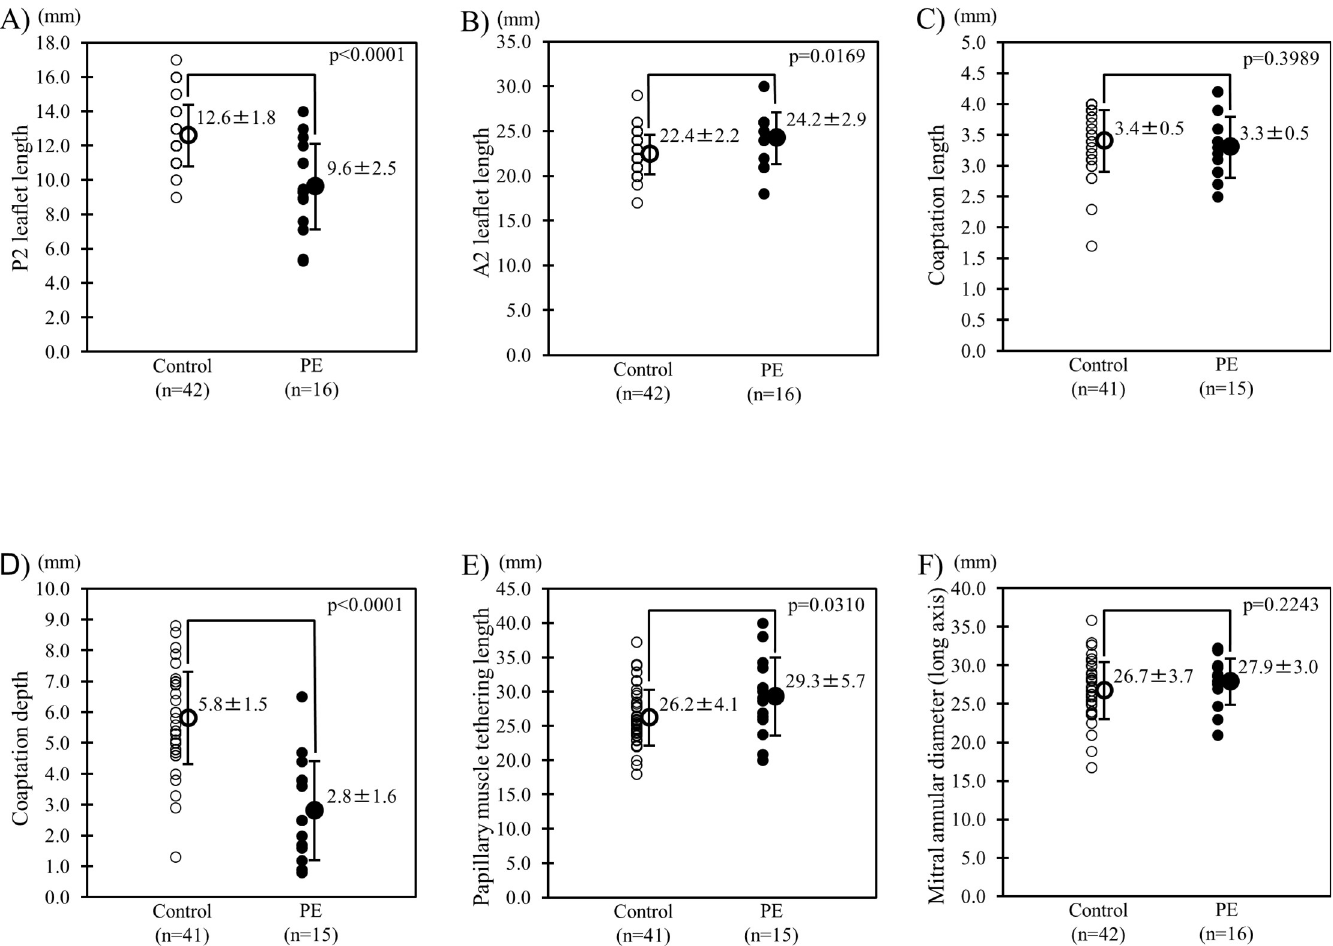
Fig 4. Comparison of the mitral leaflet length, coaptation length and depth, and papillary muscle tethering length, and mitral annular diameter between normal controls and patients with pectus excavatum (PE). Comparison of the actual P2 (A), A2 length (B), coaptation length (C) and depth (D), papillary muscle tethering length (E), and mitral annular diameter (F) between normal controls and patients with PE older than 16 years.